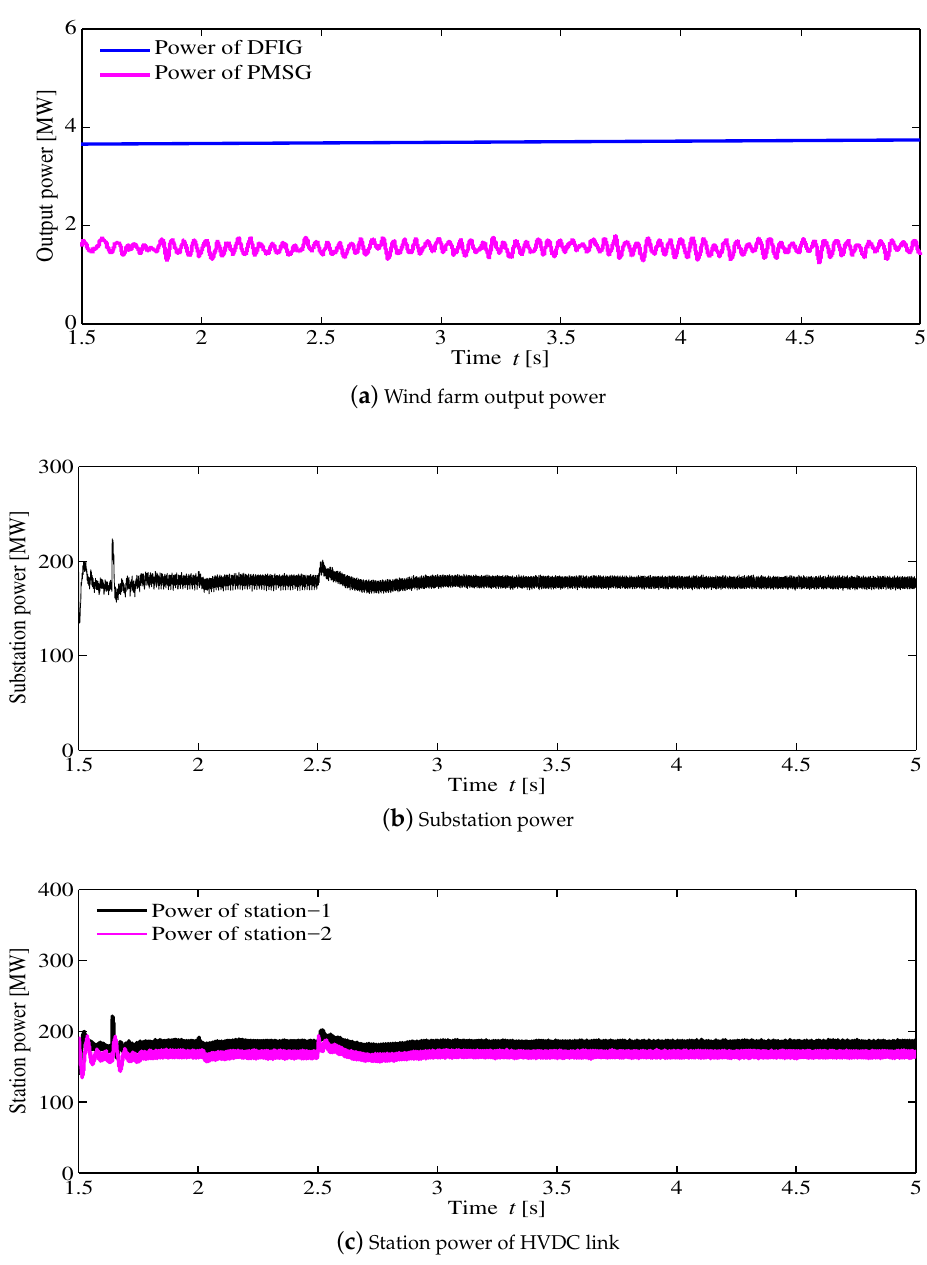
Figure 10. Simulation results of the generated